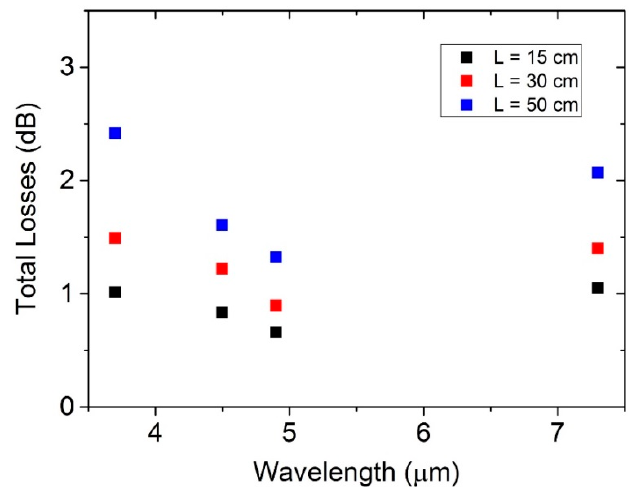
Figure 5. ( a – d ) Total losses as a function of the QCLs emitting wavelengths for HCWs with L = 15 cm ( ▀ ), 30 cm ( ● ), and 50 cm (  ). ( (cid:4) ), 30 cm ( (cid:4) ), and 50 cm ( (cid:4)